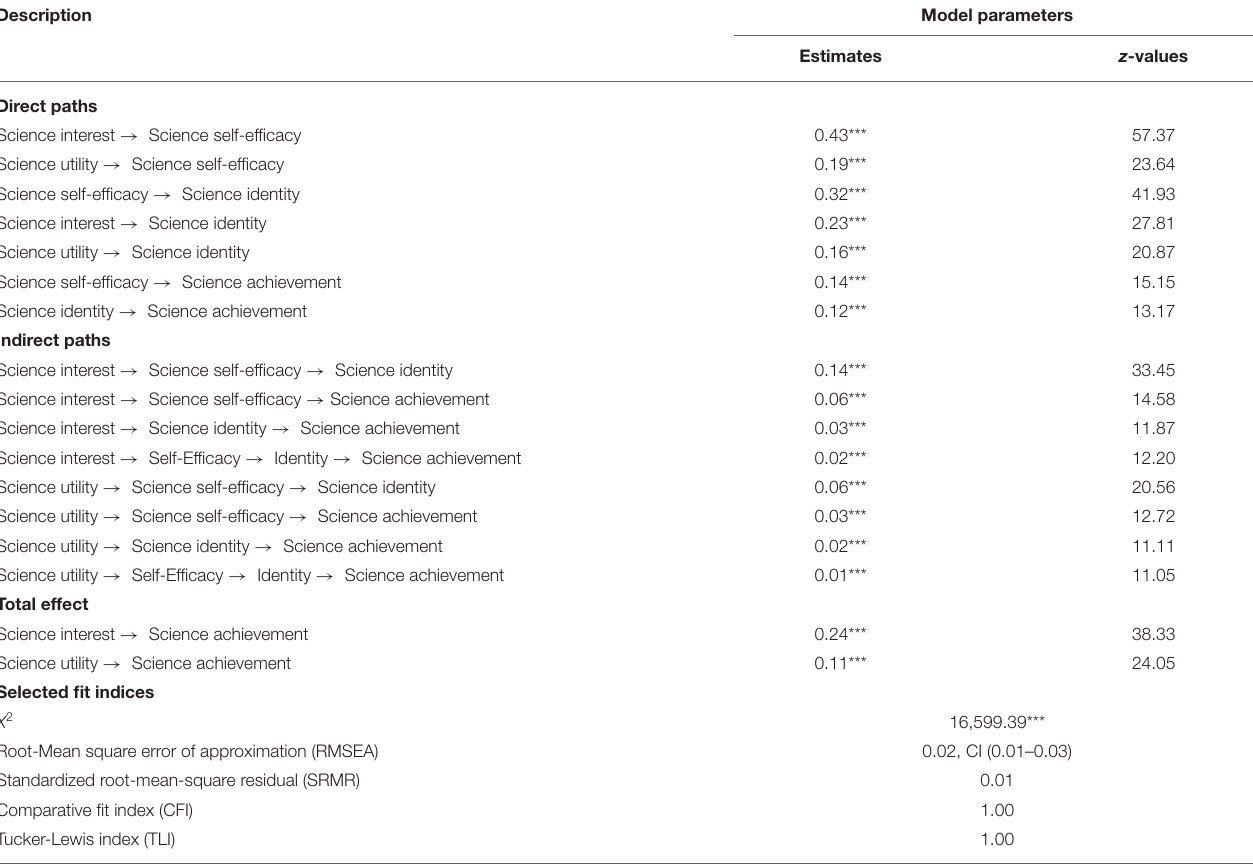
TABLE 3 | Final mediation model: maximum likelihood (standardized) estimates and selected fit